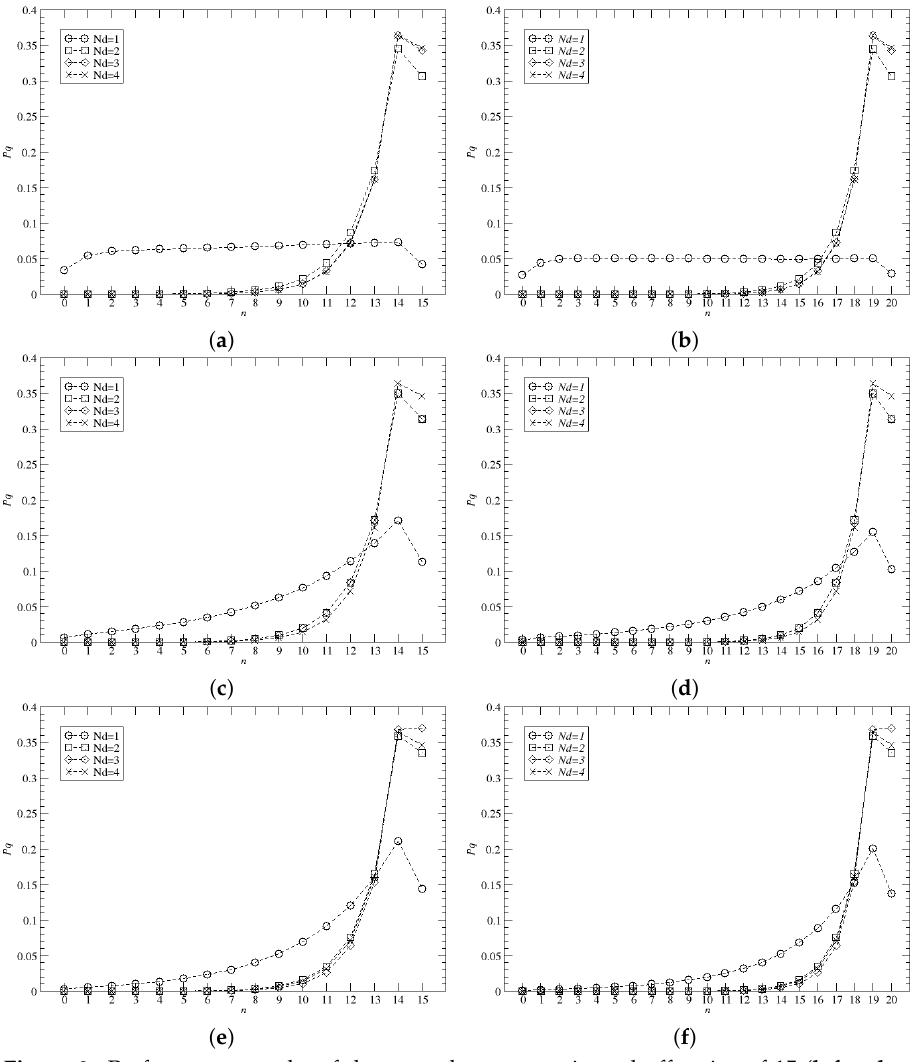
Figure 8. Performance results of the secondary user using a buffer size of 15 ( left column ) and 20 ( right column ) IUs. ( a ) Wl = 0.3, QS = 15. ( b ) Wl = 0.3, QS = 20. ( c ) Wl = 1.0, QS = 15. ( d ) Wl = 1.0, QS = 20. ( e ) Wl = 3.0, QS = 15. ( f ) Wl = 3.0, QS =